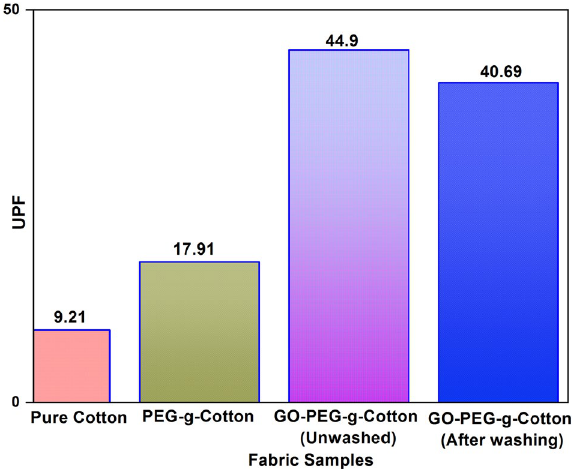
Figure 9. Assessment of ultra-violet protection factor of fabric samples.